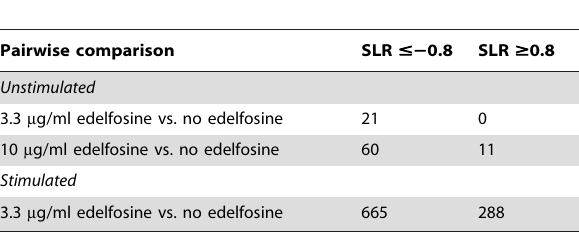
Table 1. Modulated gene expression in CD4 + T cells upon culture with